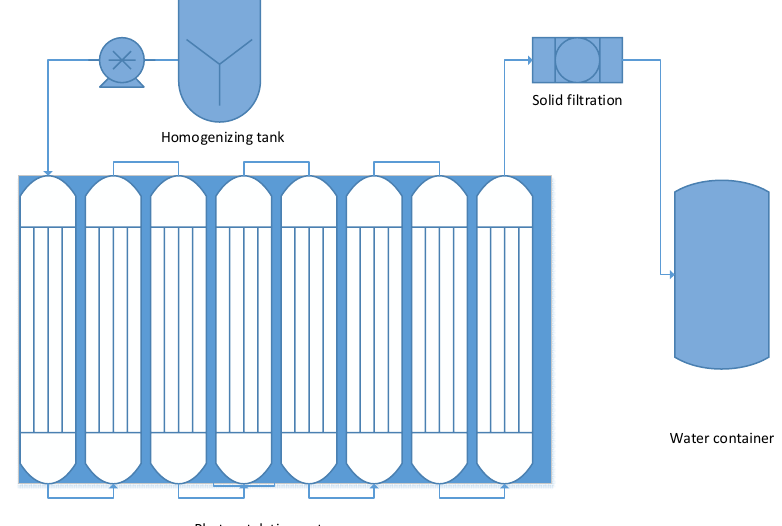
Figure 12. Proposed design for a pilot plant.